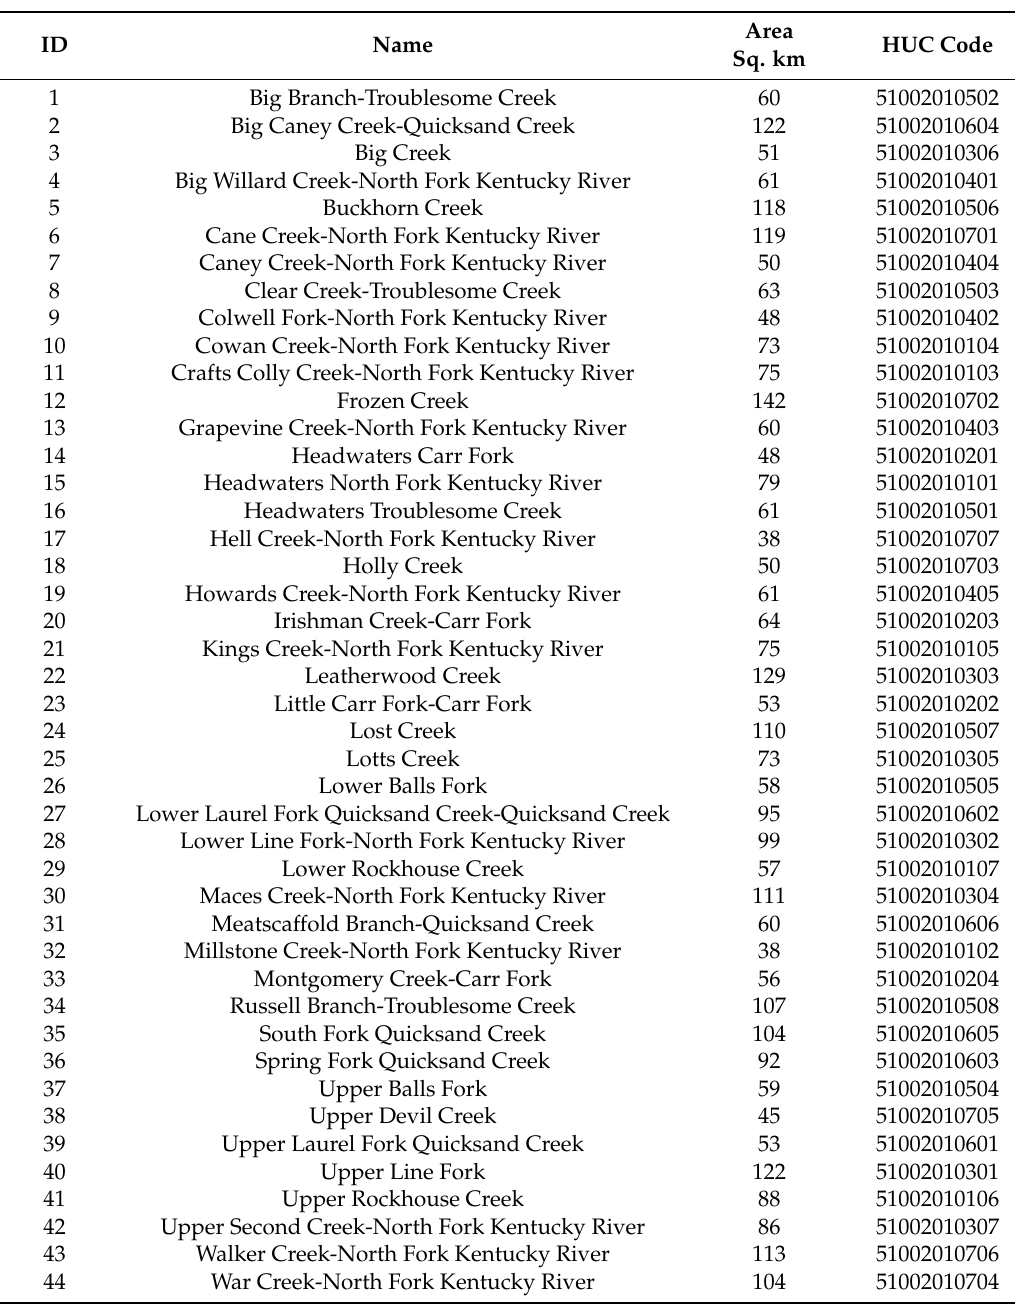
Table A1. The ID, name, area, and HUC of the 44 Subwatersheds in the NFKR